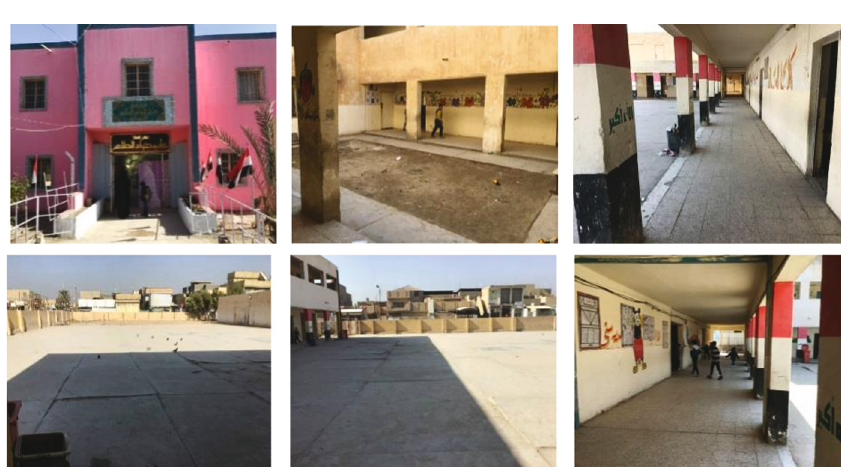
Figure 2: Scenes from local schools.